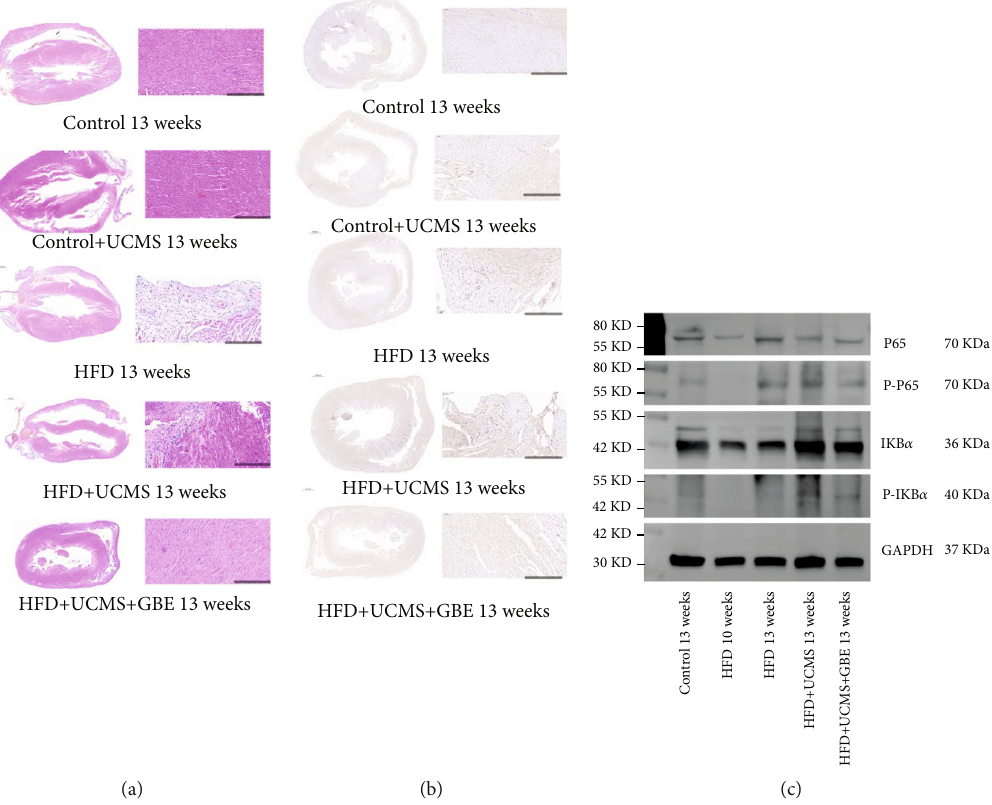
Figure 6: Cardiac function by pathology and in fl ammation by western blotting. (a) The HE-stained sections of cardiac muscles indicate there were a variety of lymphocytes in the cardiac sections of HFD+UCMS rats and HFD rats; scale bar: 10000 μ m and 500 μ m; (b) immunohistochemical staining of myocardia showing the distribution of IL-1 β ; scale bar: 10000 μ m and 500 μ m; (c) the expression of P65, P-P65, I κ B, and P-I κ B in cardiac tissue by western